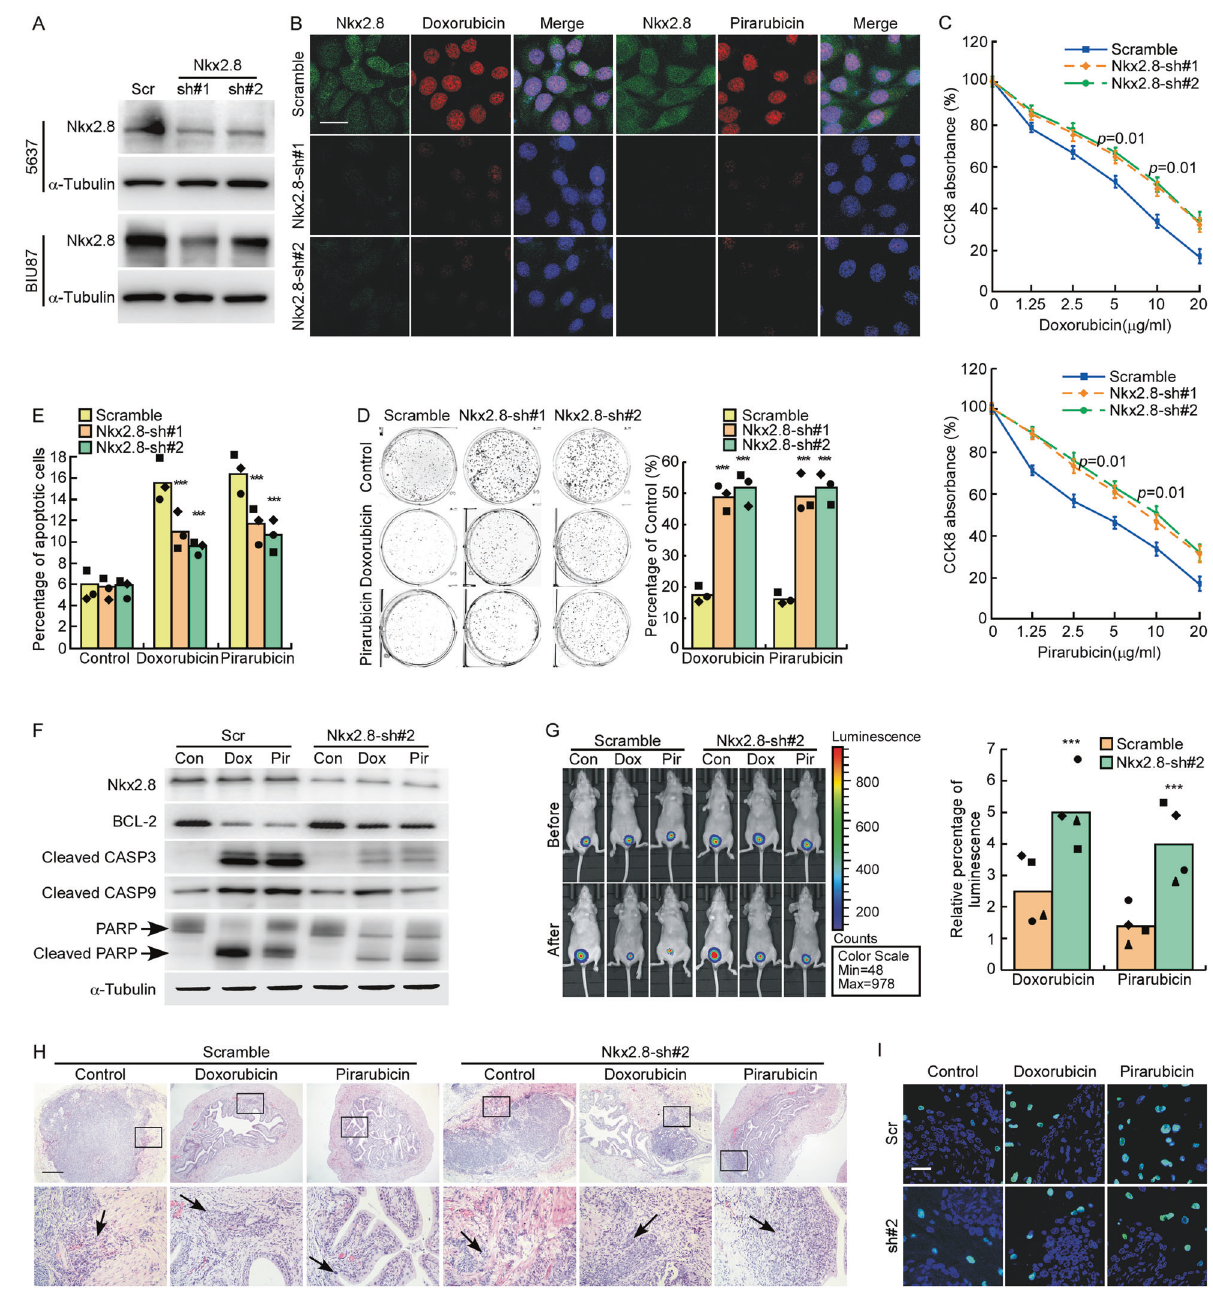
Fig. 3 Knocking-down endogenous Nkx2.8 inhibits the in vitro and vivo chemosensitivity of UC cells. A Western blot analysis of Nkx2.8 in Nkx2.8-silenced UC cells. B Immuno fl uorescence of Doxorubicin and Pirarubicin density in 5637 with scramble or Nkx2.8 knocking-down. Nuclear DNA was stained with DAPI. Scale bar, 20 μ m. C CCK8 analysis of scramble or Nkx2.8 knocking-down 5637 after treated by different dose of Doxorubicin (left) or Pirarubicin (right) (mean ± SD). p values are indicated (two-tailed t test, n = 3). D Colony formation assays of scramble or Nkx2.8 knocking-down 5637 after treated by Doxorubicin or Pirarubicin (left panel) and quanti fi cation (right panel) of colonies (mean ± SD). *** p < 0.0001 (twotailed t test, n = 3). E The apoptosis rate of scramble or Nkx2.8 knocking-down 5637 after treated by Doxorubicin or Pirarubicin (mean ± SD). *** p < 0.0001 (two-tailed t test, n = 3). F Western blot analysis of apoptotic markers in scramble or Nkx2.8knocking-down 5637 after treated by Doxorubicin or Pirarubicin. G Representative images of macroscopic orthophoric bladder urothelial cancer generated from scramble cells or Nkx2.8 knocking-down 5637 before or after treated with Doxorubicin (Dox) or Pirarubicin (Pir) (left panel). Quanti fi cation of luminescence in orthophoric bladder urothelial cancer (right panel) mean ± SD. *** p < 0.0001(two-tailed t test, n = 4). H Representative images of H&E staining. Scale bar, 500 μ m. I TUNEL assay of apoptosis in tumor tissues. Scale bar, 20 μ eosin (H&E) staining also showed that after intravesical instilled instilled into the nude mice urinary bladder intravesically once a with drug, mice implanted with T24/Nkx2.8 cells had mild week for 4 weeks. Bioluminescent imaging showed that after drug aggressive tumor while those implanted with T24/vector cells treatment, mice instilled with T24/Nkx2.8 cells had signi fi cantly had signi fi cant muscle invasive tumor (Fig. 2H). The terminal weaker bioluminescent signal than mice instilled with T24/vector deoxynucleotidyl transferase-mediated dUTP nick end-labeling cells, compared to control group (Figs. 2G and S1F). Hematoxylin